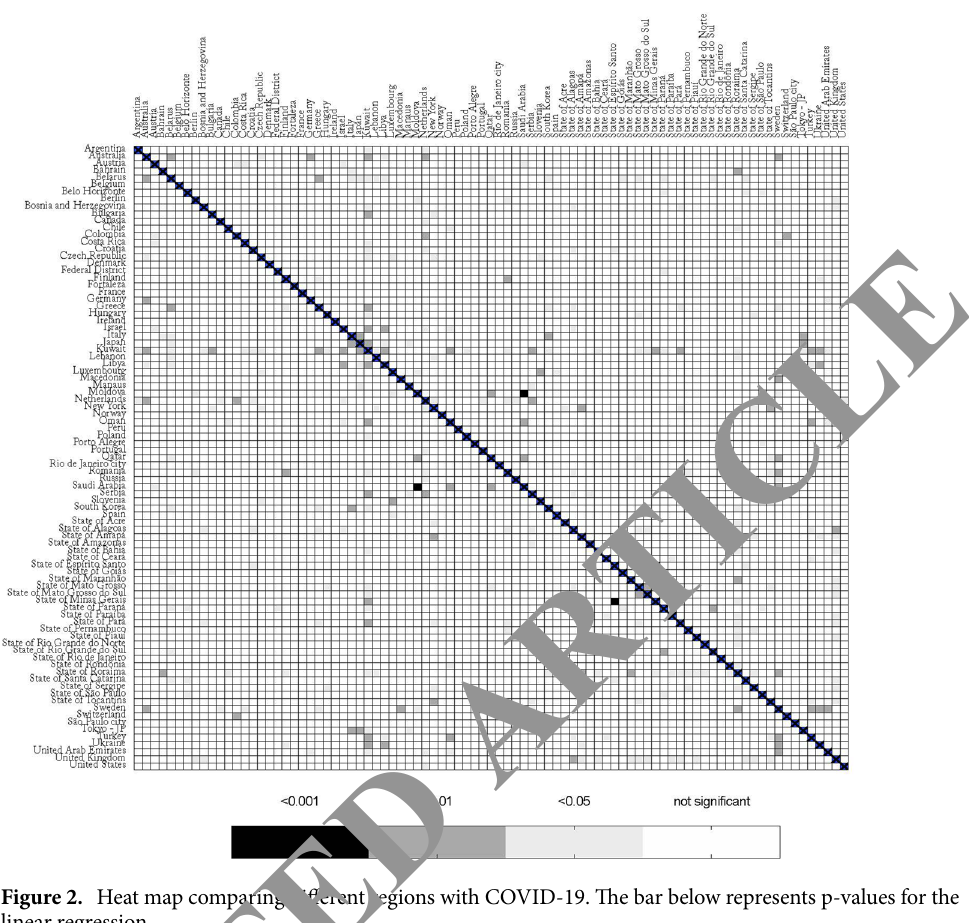
Figure 2. Heat map comparing different regions with COVID-19. The bar below represents p-values for the linear